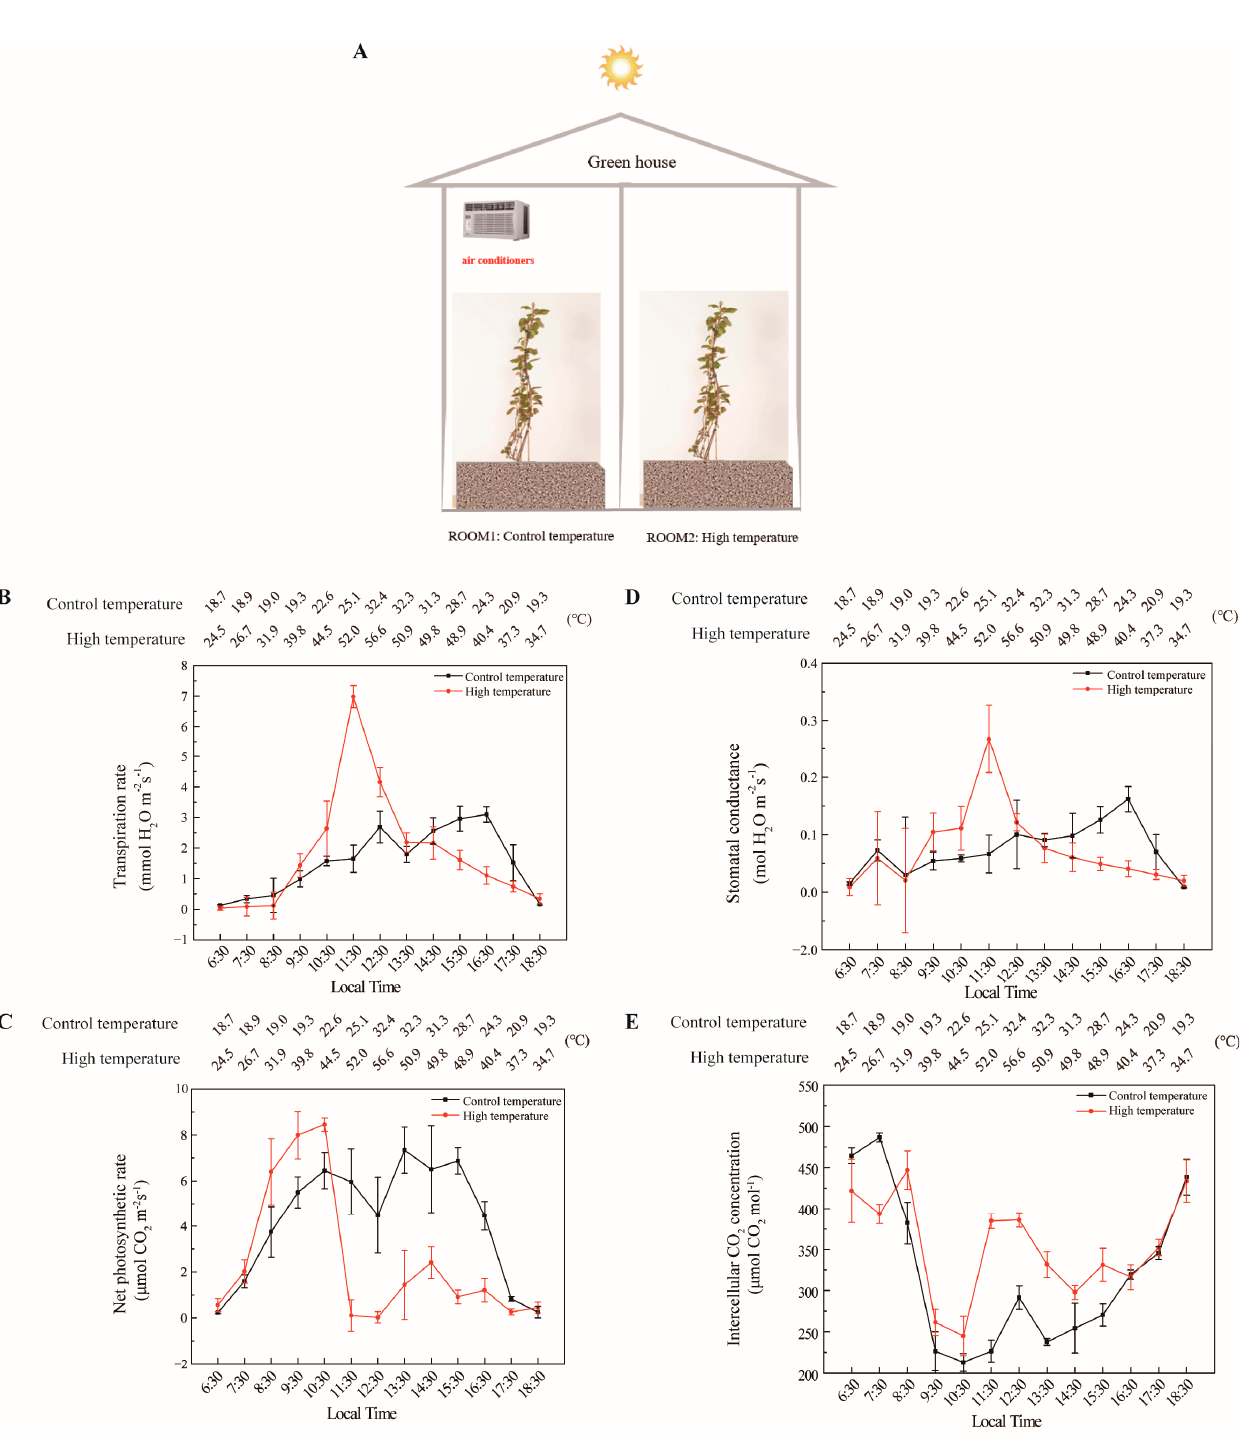
Figure 4. Effect of high-temperature stress on photosynthesis of yellow-fleshed tetraploid kiwifruit genotype ( A.chinensis). Greenhouse experimental rooms ( A ), transpiration rate ( B ), net photosynthetic rate ( C ), stomatal conductance ( D ) and intercellular CO 2 concentration ( E ).